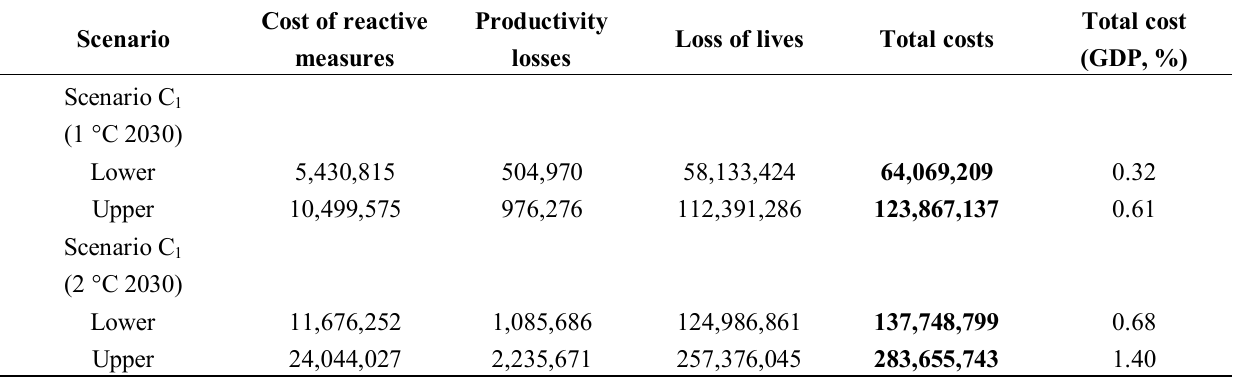
Table 3. Annual costs of cholera attributable to climate change by 2030 in Tanzania